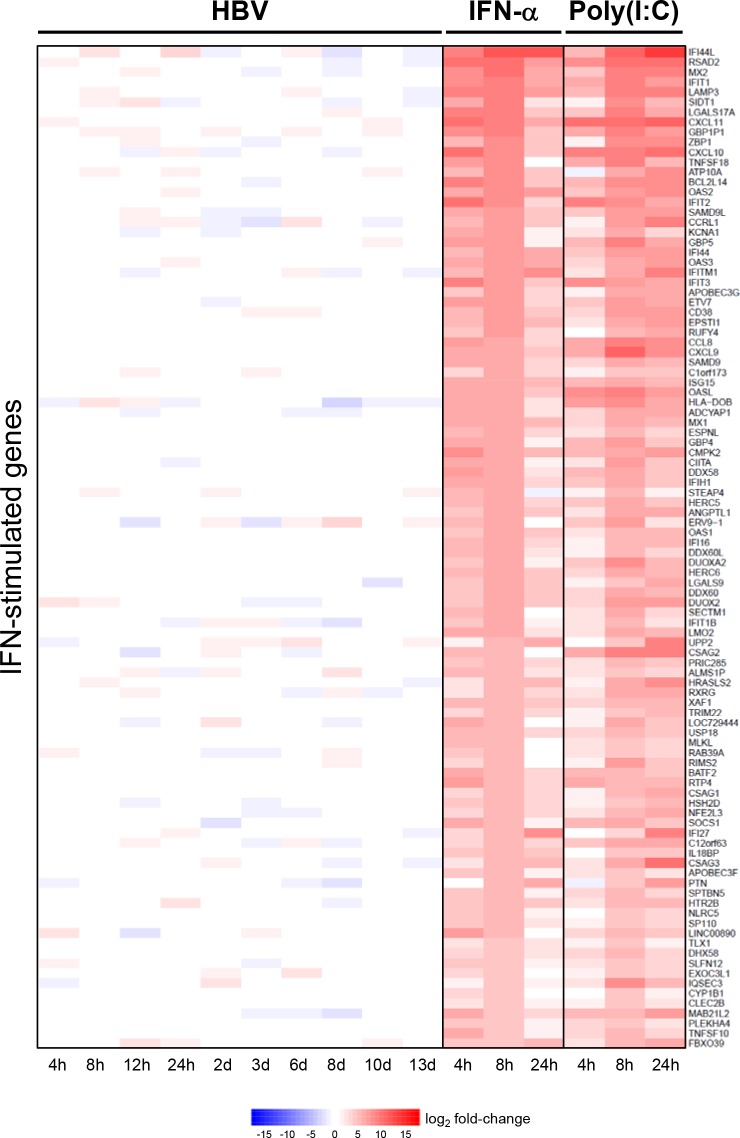
HBV infection does not induce ISG expression in PHH.Expression of top IFN-induced genes in PHH infected with HBV or treated with either IFN-α or poly(I:C) plotted by mean log2 fold-change of two independent donors. Heatmap columns represent comparisons relative to time-matched mock-infected control. Rows represent individual genes; over-expression (red) and under-expression (blue) indicated by scale bar for log2 fold change values. All genes (n = 100) had a mean fold-change >2 and a false discovery rate (FDR) <0.05 at 8 hours post-treatment with IFN-α relative to the time-matched mock-infected control, and passed a low-expression filter. None of these genes were identified as DEGs at any time post-infection with HBV (S2 Table).